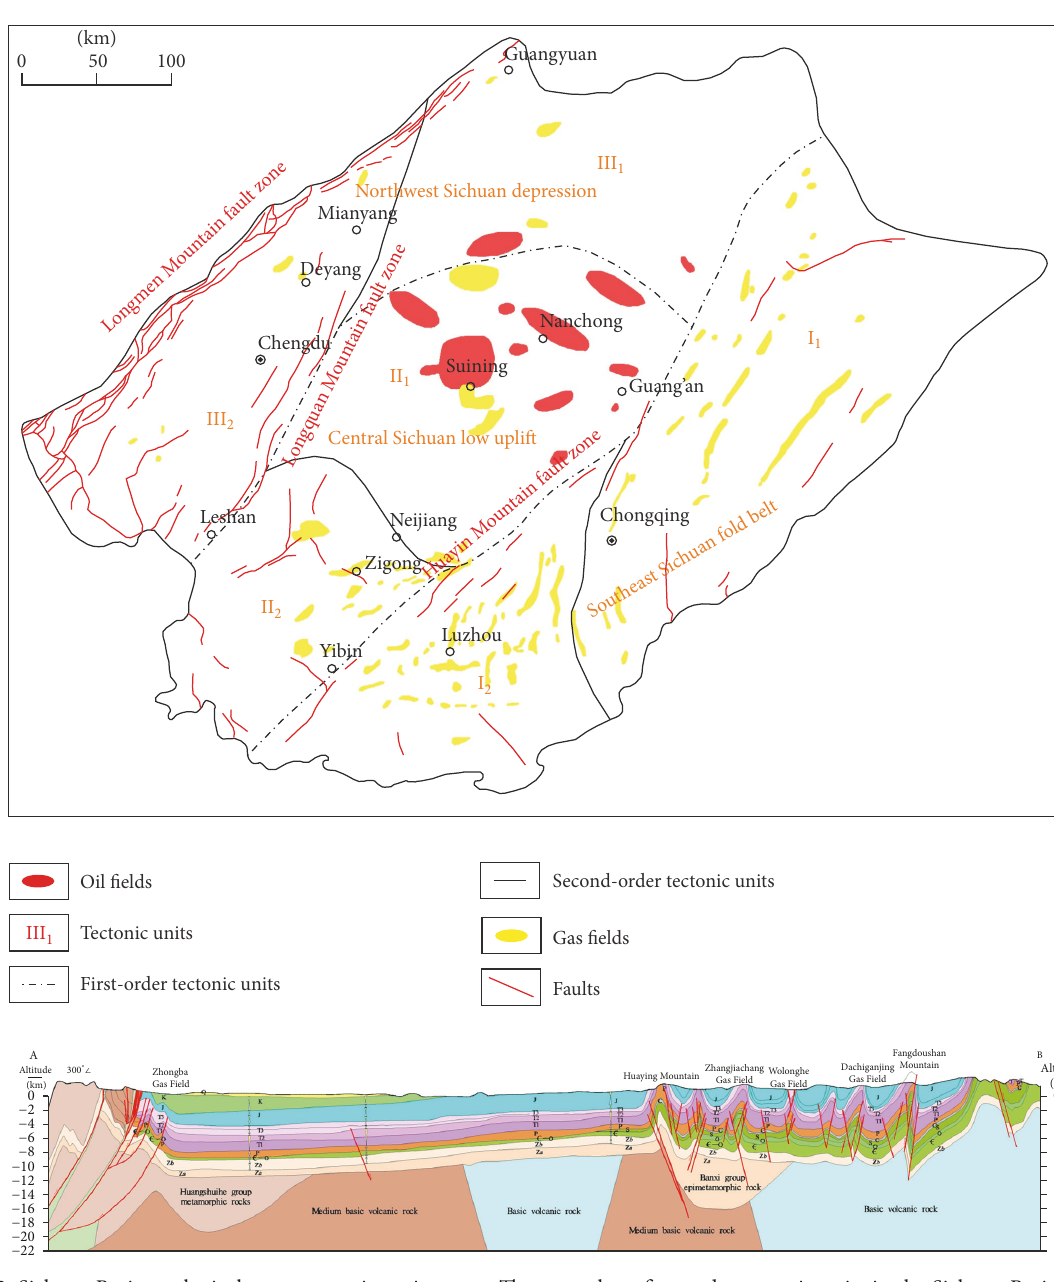
Figure 2: Sichuan Basin geological structure unit zoning map. There are three first-order tectonic units in the Sichuan Basin, that is, the Southeast Sichuan fold belt, the Central Sichuan low uplift, and the Northwest Sichuan depression. The Southeast Sichuan fold belt consists of the high steep fold belt in Eastern Sichuan (I1) and the low steep bottom fold belt in Southern Sichuan (I2); the Central Sichuan low uplift is composed of the flat fold belt in Central Sichuan (II1) and the low steep fold belt in Southwestern Sichuan (II2); the Northwest Sichuan depression consists of the low-lying fold belt in Northern Sichuan (III1) and the low steep fold belt in Western Sichuan